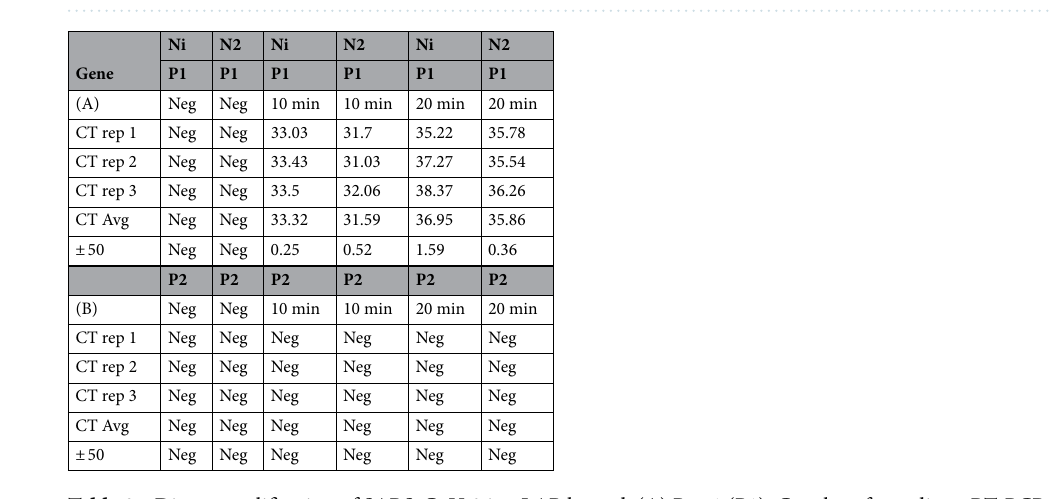
Table 2. Direct amplification of SARS-CoV-2 in vLAB heated. (A) Pass1 (P1): Ct values from direct RT-PCR amplification using as template 2 µl of lysates of SARS-CoV-2 virus in vLAB (diluted 1:10) heated. The samples were incubated at 65 °C for 10 (light red) and 65 °C for 2 min (orange) and then were tested by RT-PCR. Neg = non detected, only MEM culture media. (B) Pass 2 (P2): CT values from direct RT-PCR amplification using as template 2 µl of supernatants from P1, samples were incubated as described previously. Neg = Non detected, Rep = repetition, CT = cycle thresholds, N1 and N2 = nucleocapsid gene 1 and 2. vLAB = virus Lysis Amplification